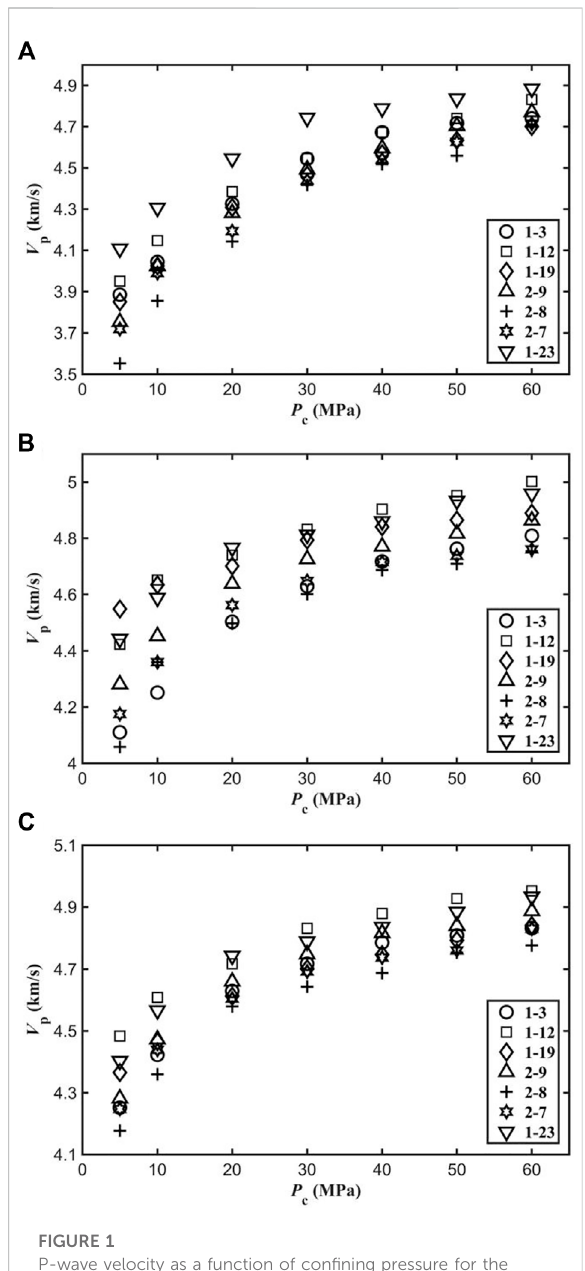
FIGURE 1 P-wave velocity as a function of con fi ning pressure for the seven samples at gas- (A) , water- (B) and oil- (C) saturation